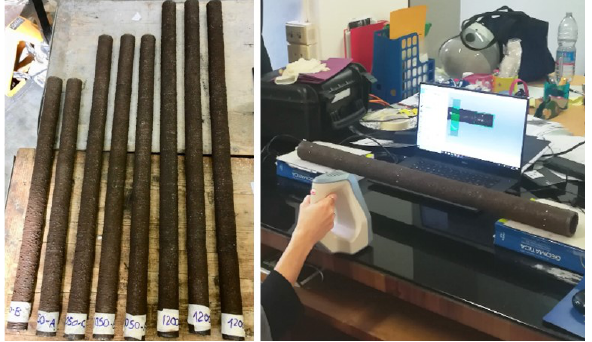
Figure 10. a) Circular tubular elements realized with the WAAM technology; b) 3D scanning of one specimen (Laghi et al., 2020).